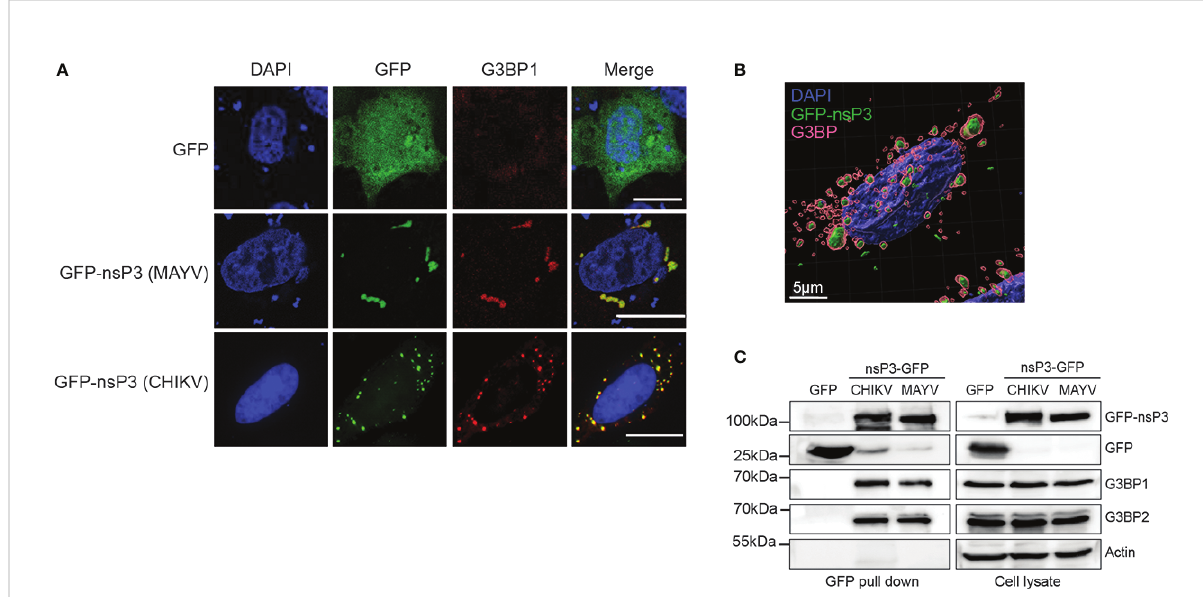
FIGURE 5 MAYV GFP-nsP3 interacts with G3BP and co-segregates in cytoplasmic foci. (A) HeLa cells transfected with GFP, MAYV GFP-nsP3, or CHIKV GFP-nsP3 expression vector were processed for immuno fl uorescence using anti-G3BP1 antibodies. Nuclei were visualized with DAPI staining, and cells were observed in confocal microscopy. Scale bars are 20 µm. (B) 3D image reconstruction was performed from confocal images and z-stacks acquired from cells expressing the MAYV GFP-nsP3 protein. (C) Total cell extracts prepared from (A) were pulled down using GFP-Trap. Lysates and pulled complexes were separated by SDS-PAGE and probed for GFP, G3BP1, G3BP2, and actin. Results are representative of two distinct